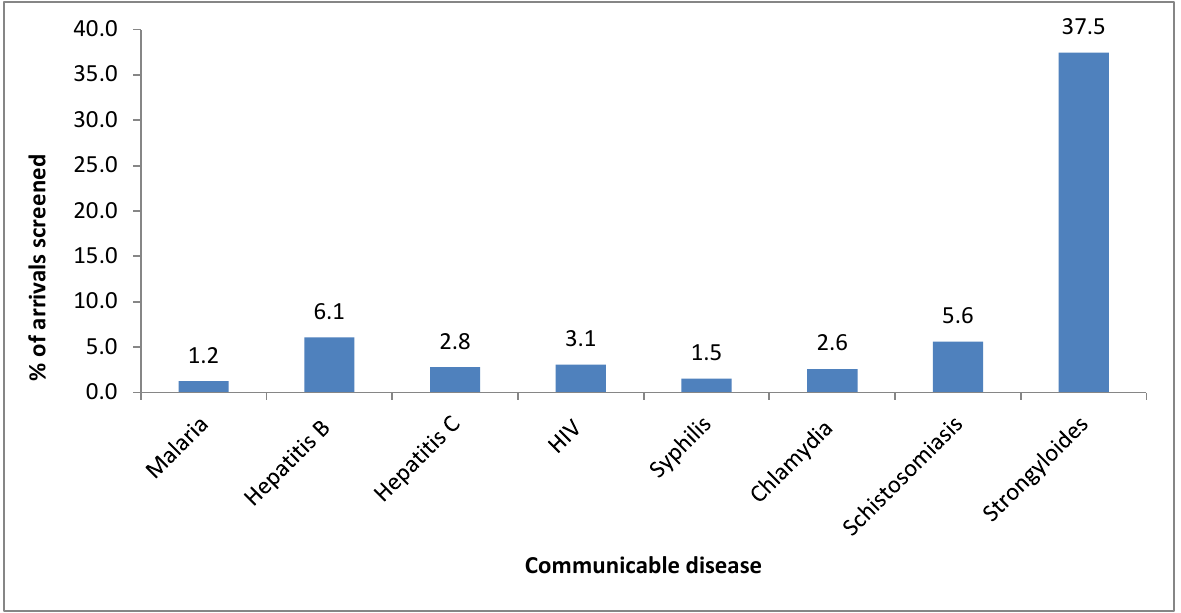
Figure 12: Communicable diseases found in Congolese refugees during domestic medical examinations in 6 states from 2010 – 2013